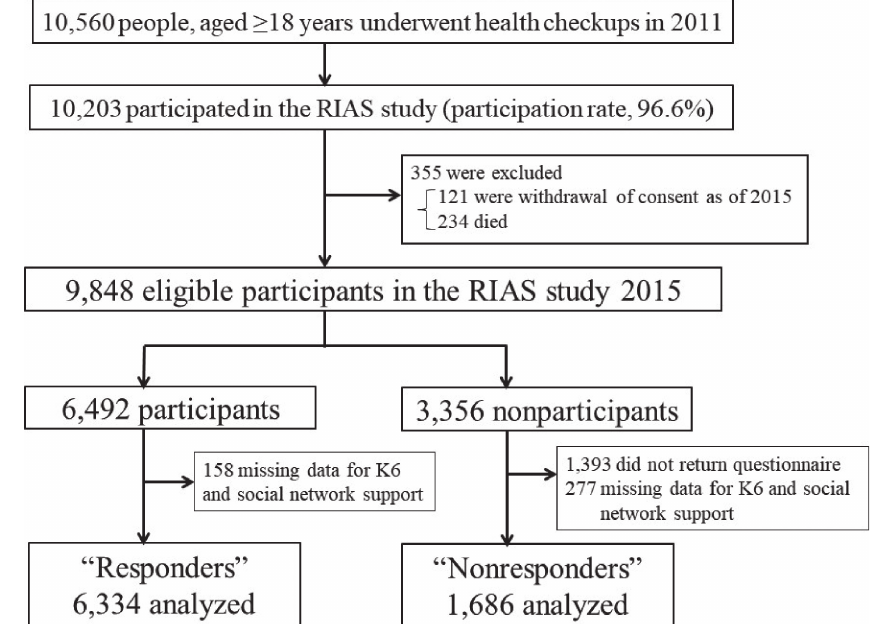
Figure 1. Flowchart depicting responders and nonresponders in the Research Project for Prospective Investigation of Health Problems Among Survivors of the Great East Japan